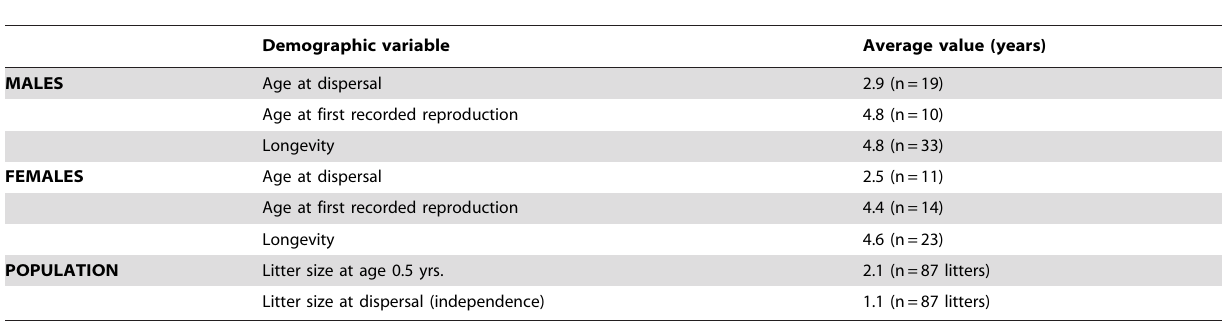
Table 4. Baseline demographic variables for giant otters in Manu National Park.